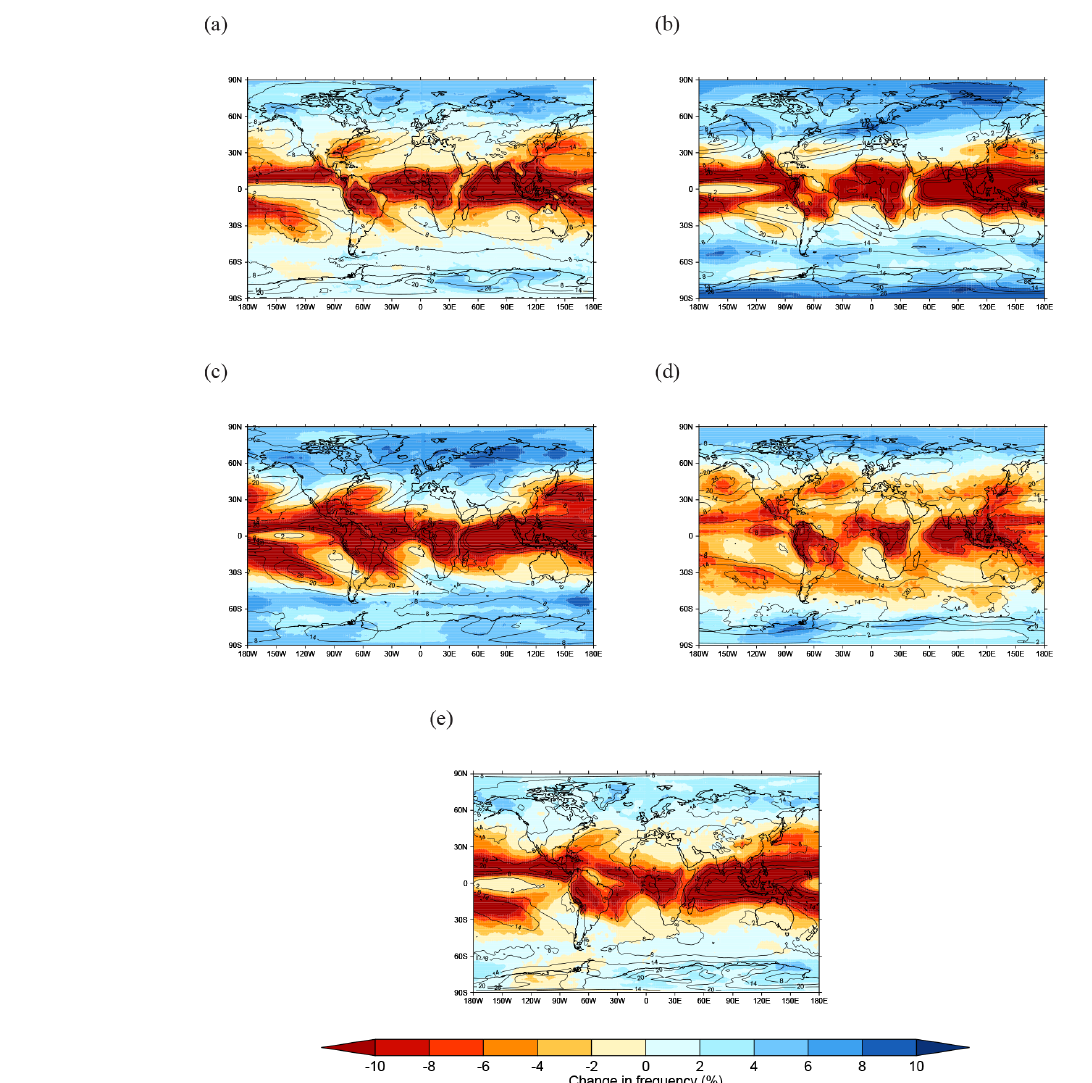
Figure 4. Change in mean CISS frequency at 250hPa (colours) in percentage points between the RCP8.5 simulation (average over 2073– 2099) and historical simulation (average over 1979–2005) for the CMIP5 models (a) EC-EARTH, (b) GFDL-ESM2G, (c) HadGEM2-CC, (d) MIROC5 and (e) MPI-ESM-MR. The mean CISS frequency (in %) in each model over the historical period 1979–2005 is overlaid (black contours – starting at 2%, with a 6% contour